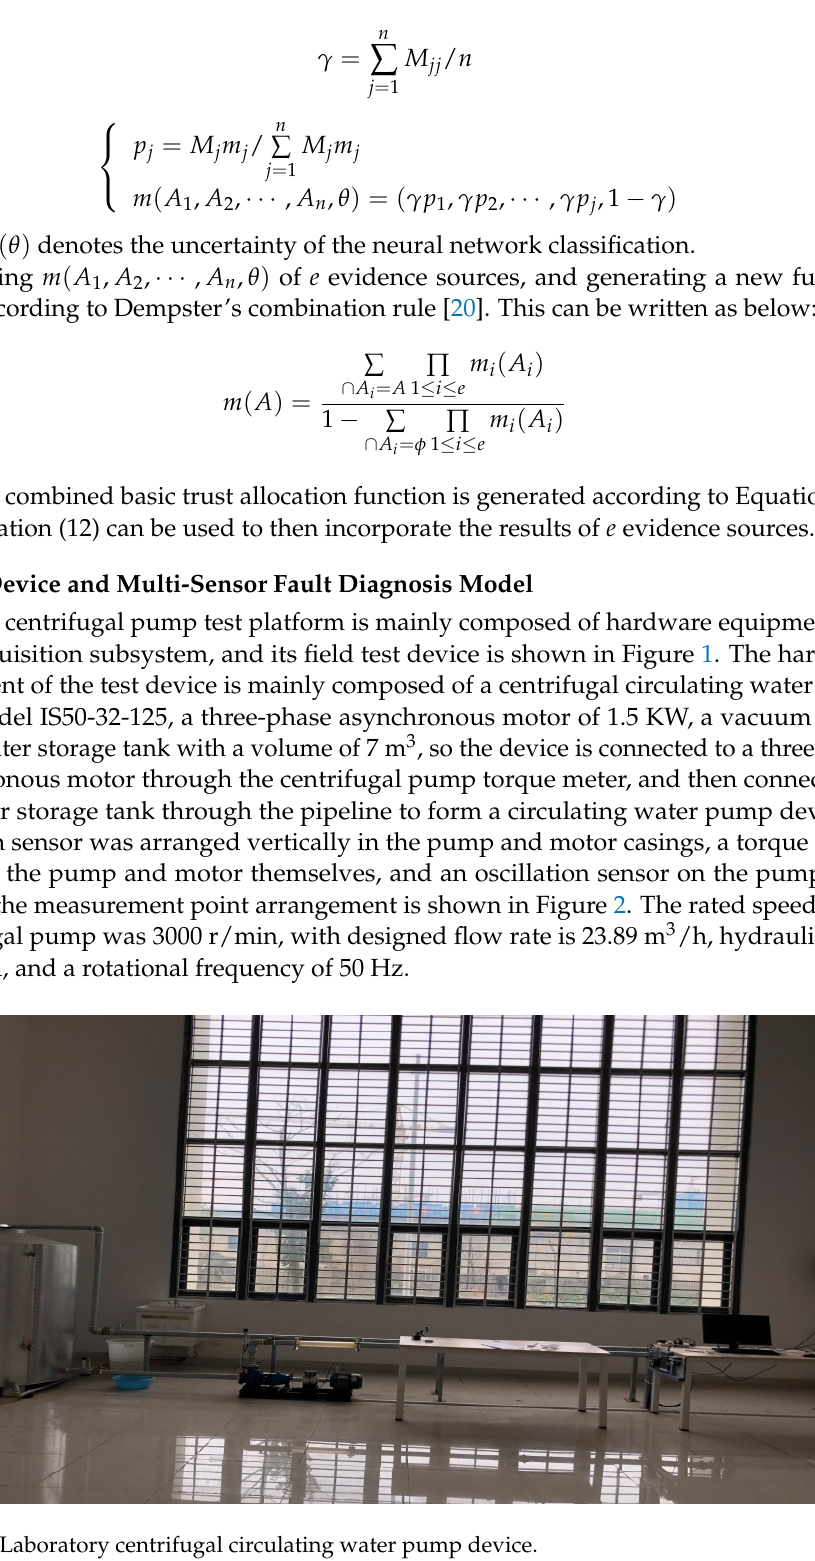
Figure 2. Centrifugal pump test device. This test adjusts the inlet pressure by adjusting the vacuum pump pumping, simu- lates the cavitation phenomenon under different inlet pressures and through the loos- ening of the preload between the anchor bolt and the base, a total of four sets of operat- ing conditions (i.e., normal operation, slight cavitation, severe cavitation, and loose bolts of the centrifugal pump) were designed. Moreover, four signals, for the centrifugal pump vibration, torque, motor vibration, and pump shaft +X oscillation, were obtained through the PXI-4472B dynamic signal acquisition instrument under these different op- erating conditions. These were then processed using the improved MFDFA to extract the multiple fractal spectrum feature parameters of each signal, i.e.,